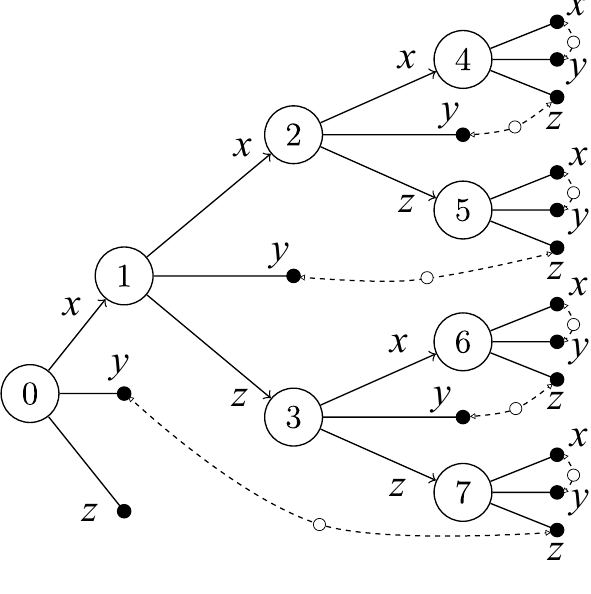
Figure 7: Pair of nodes in binary x-z Υ ◦